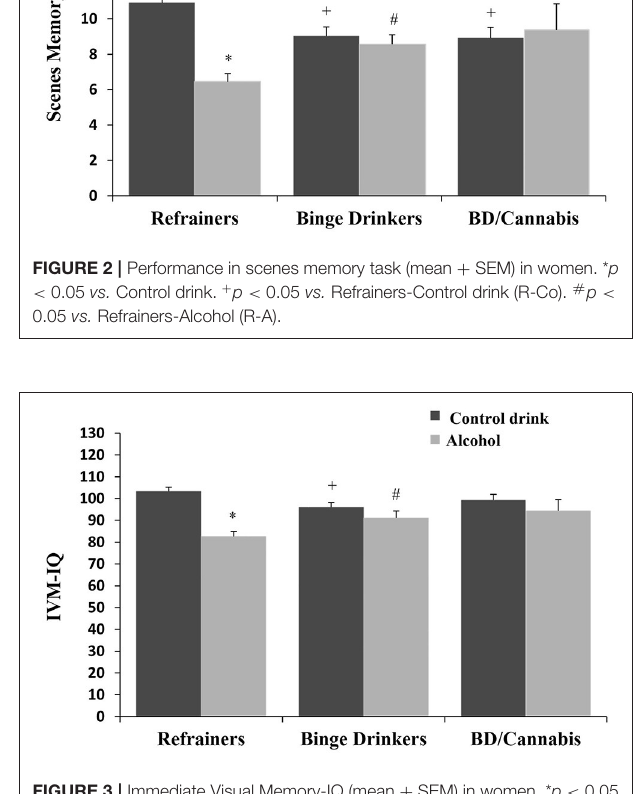
FIGURE 3 | Immediate Visual Memory-IQ (mean + SEM) in women. * p < 0.05 vs. Control drink. + p < 0.05 vs. Refrainers-Control drink (R-Co). # p < 0.05 vs. Refrainers-Alcohol